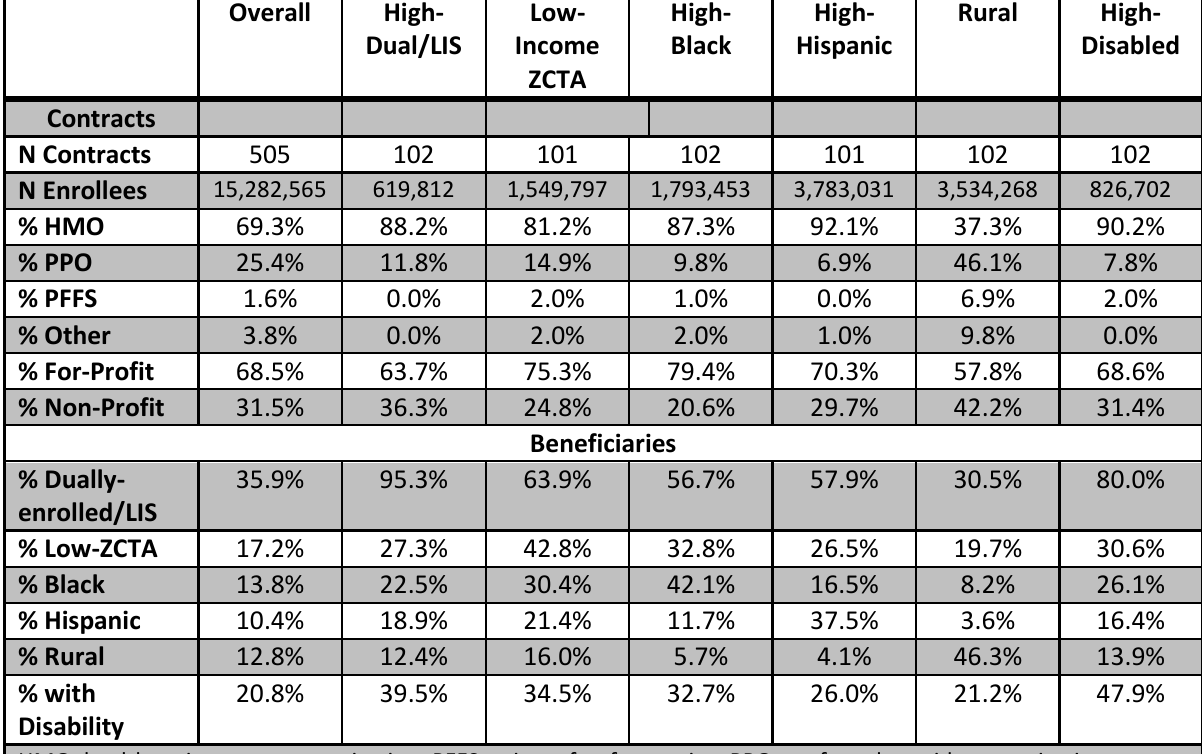
Table 8.2: Contract